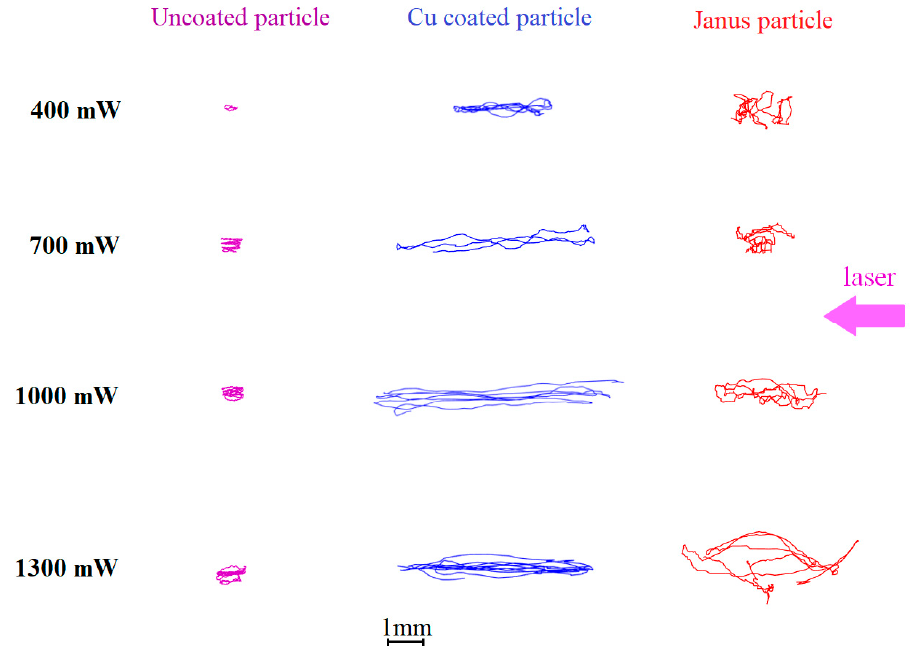
Figure 3. Side View (vertical component of the active Brownian motion). Dust particle trajectories in the DC discharge stratum during the time ∆ t = 1 s, at different laser powers W las : 400, 700, 1000 and 1300 mW. Left row is uncoated dust particle; the central row is the Cu-coated dust particle; right row is the dust Janus particle.